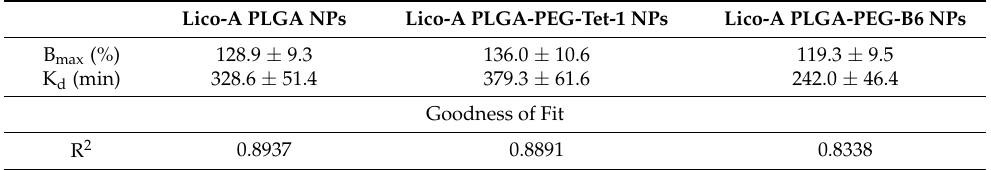
Table 4. Release data fitted to a hyperbola equation (meaning K d , half of the time when Lico-A is released at equilibrium and B max maximum % of Lico-A released).